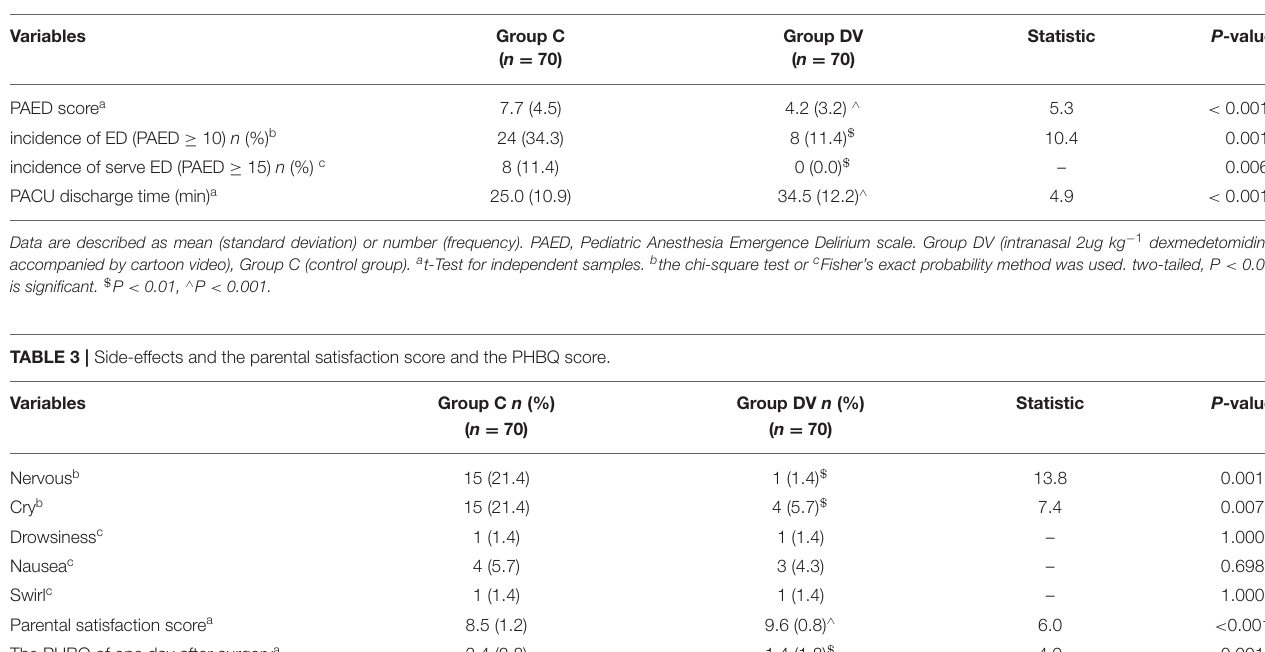
TABLE 2 | Postoperation situation in PACU.